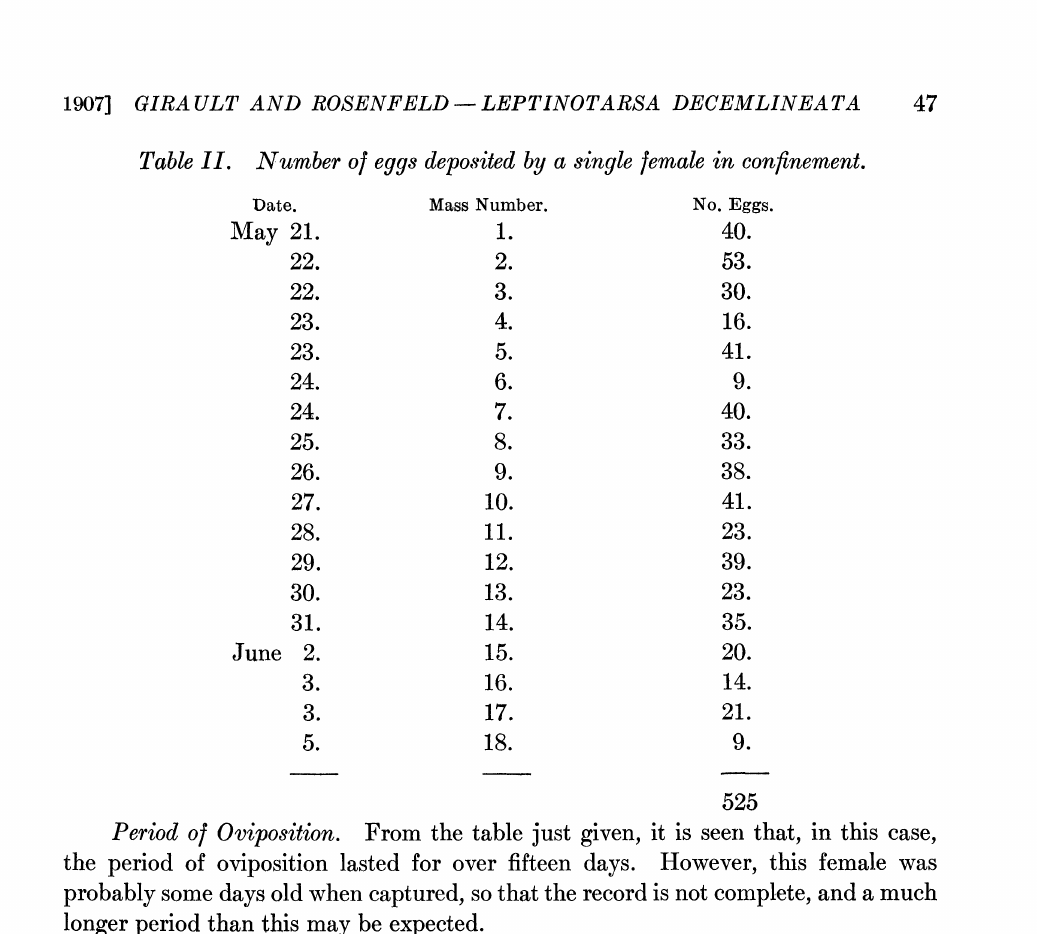
Table II. Number o] eggs deposited by a single ]emale in confinement.